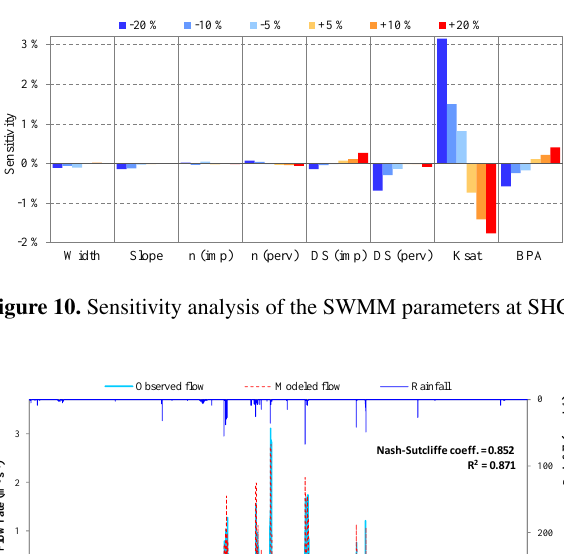
(48.3 mm d − 1 ) based on the storm statistics for the study area